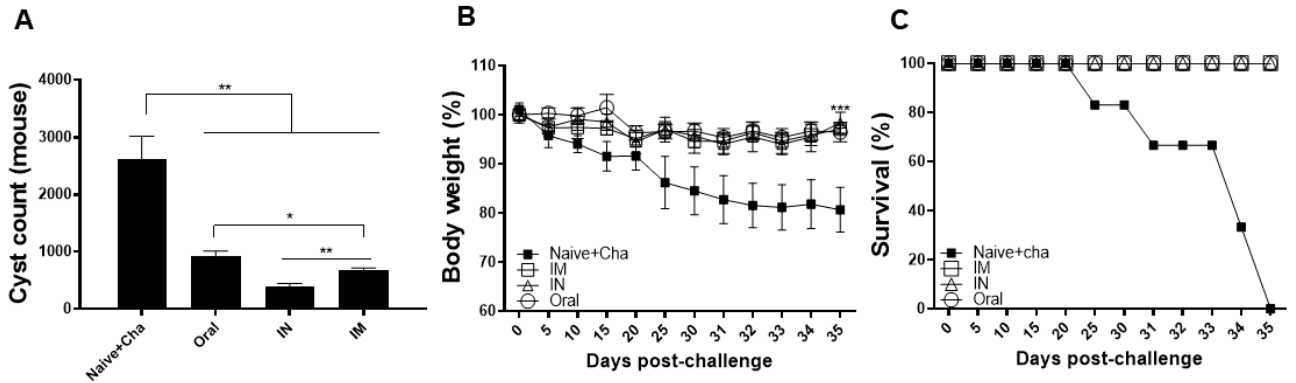
Figure 7. Cysts were isolated from the brain tissues of mice and counted under the microscope ( A ). Changes in body weight ( B ) and survival ( C ) were recorded daily until 35 dpi. Data are presented as mean ± SD and asterisks indicate statistical differences between groups. (* p < 0.05, ** p < 0.01, *** p <